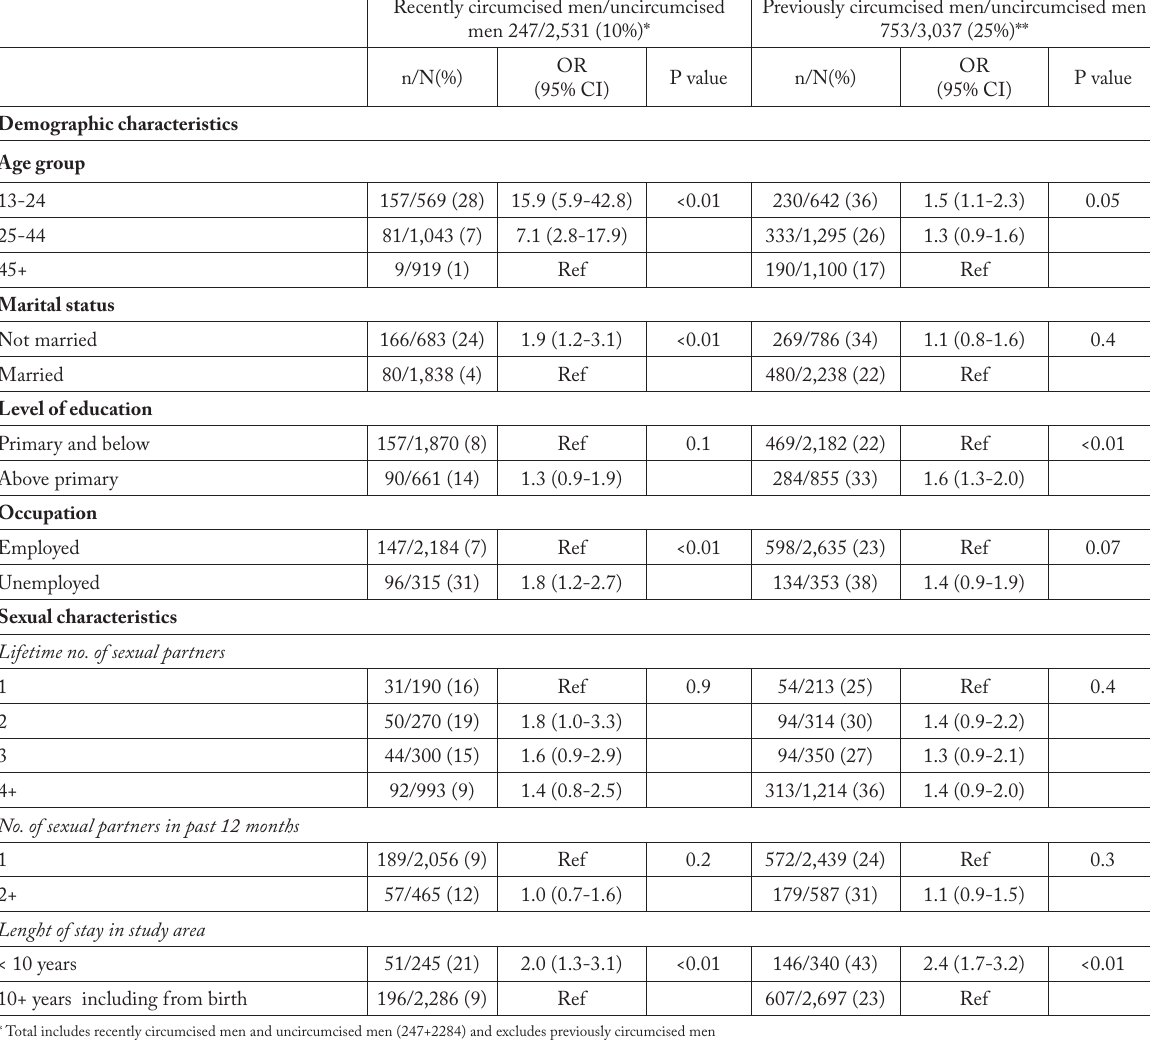
Table 2. Factors associated with circumcision status by timing of circumcision among Male Respondents in Gem, Siaya County, Western Kenya, 2012-2014 (All male participants: n =